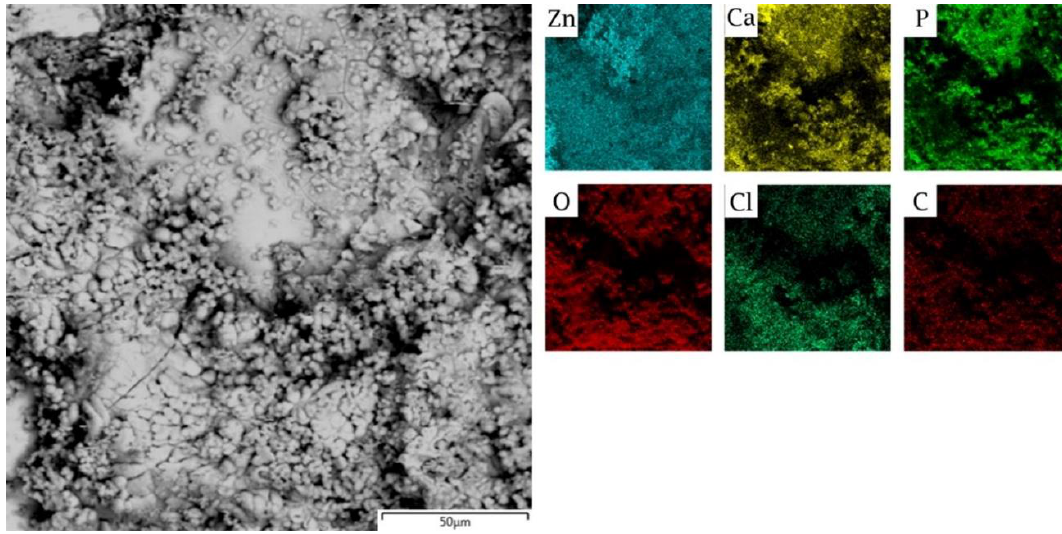
Figure 12. X-ray elemental distribution of the corrosion products on the Zn/HA composite (SEM–